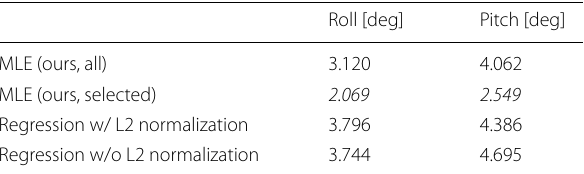
Table 7 MAE of estimated attitude in unknown environment